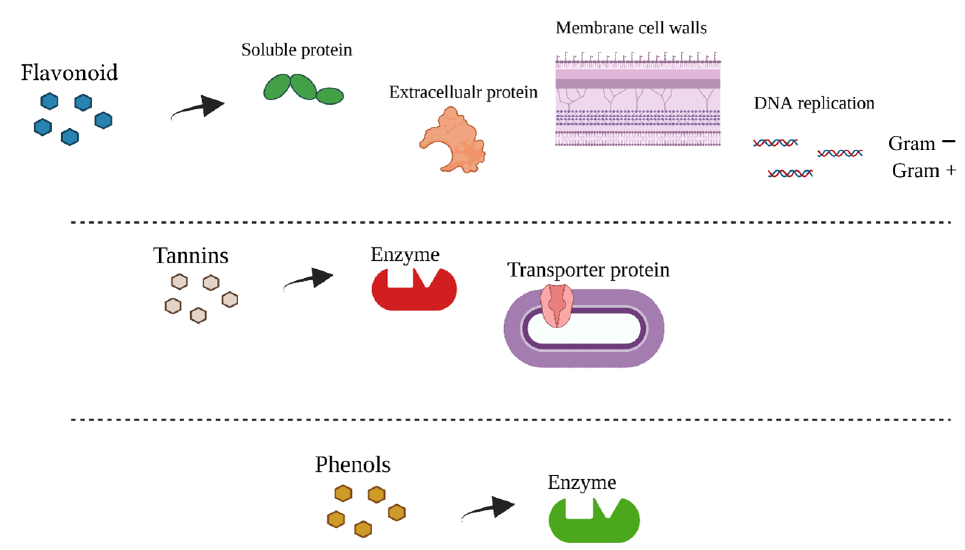
Figure 2. Flavonoid, tannin and phenol antimicrobial mechanisms of